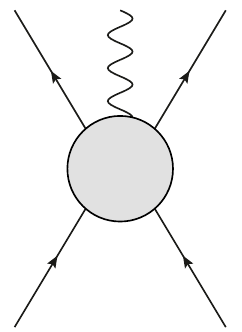
Figure 1. Two particle scattering with the production of radiation. This is the basic structure of diagrams we will be interested in. Note that time is on the vertical